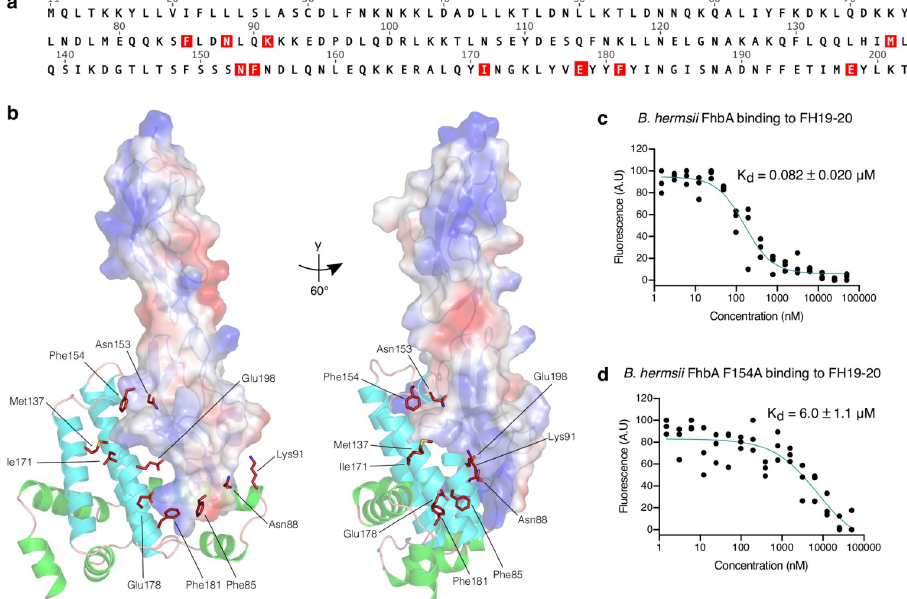
Fig 2. Binding of FH20 to BhFhbA is mediated by a hydrophobic binding pocket. (a) The sequence of BhFhbA from Borrelia hermsii YOR (UniprotID: W5SB08) with mutated residues marked in red. (b) Positions of the mutations mapped on the structure of the BhFhbA:FH19-20 complex. BhFhbA α -helices 1–5 are shown in green, 6–9 in teal (cartoon), and FH19-20 is shown as an electrostatic surface model. (c) Binding of FH19-20 to wild type BhFhbA and (d) Phe154Ala mutant BhFhbA detected by MST. K d -values ± SEM ( μ M) calculated from three technical replicates (normalized fluorescence values) and individual data points are shown.